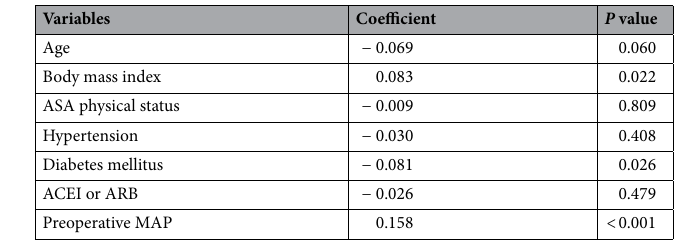
Table 3. Correlation between average real variability of mean arterial pressure and clinical factors. ASA American Society of Anesthesiology, ACEI angiotensin-converting enzyme inhibitor, ARB angiotensin receptor blocker, MAP mean arterial